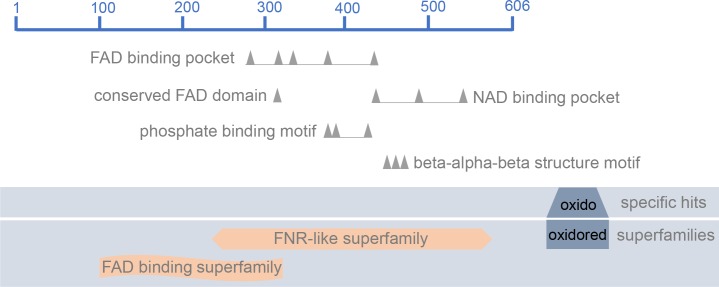
NOS-like graphical summary of conserved domains.Structure of the oxidoreductase synthase-like protein (LmxM.1950/EC 1.14.13.39) with the following conserved domains hits: ferredoxin reductase (FNR) binding domain, flavin adenine dinucleotide (FAD) binding pocket, conserved FAD binding motif, nicotinamide adenine dinucleotide (NAD) binding pocket, phosphate binding motif and beta-alpha-beta structure motif. The representation was based on in silico search of conserved domain of NCBI database.